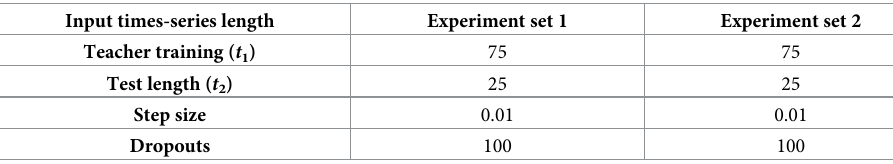
Table 3. Dataset